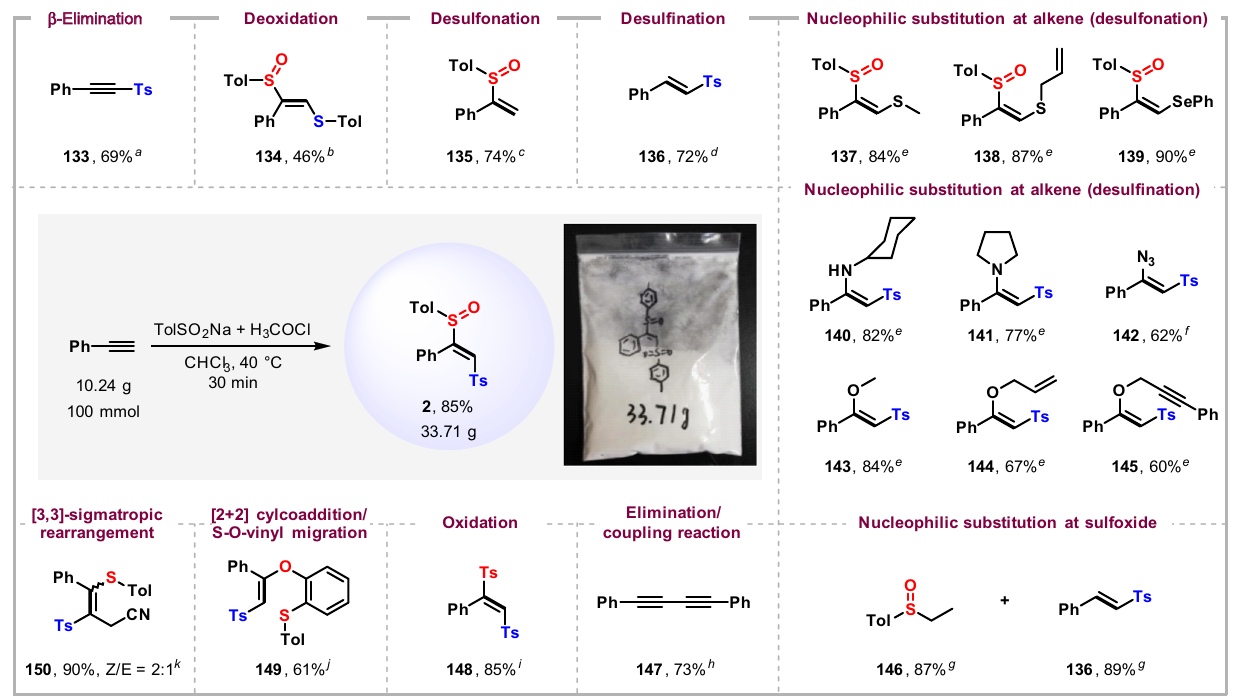
Fig. 5 Large-scale synthesis and further transformations. All yields are isolated yields. The amount of 2 is 0.5 mmol. a NaH (0.75 mmol), CH 3 CN (3.0 mL), 25 °C, 6 h. b DBU (5.0 mmol), toluene (3 mL), 100 °C, 6 h. c Methanol (5.0 mmol), hexamethylphosphoric triamide (HMPA, 2.5 mmol), SmI 2 in THF (0.1 M, 25 mL), THF (1 mL), − 20 °C, N 2 , 2 h. d SmI 2 in THF (0.1 M, 25 mL), methanol/THF (v/v = 1/1, 1 mL), 25 °C, N 2 ; then, 60 °C, 3 h. e NaH (0.75 mmol), RXH (0.75 mmol), CH 3 CN (3 mL), 25 °C, 5 h. f NaN 3 (5.0 mmol), DMSO (3 mL), 25 °C, 0.5 h. g EtMgBr (1.0 mmol), THF (3 mL), 25 °C, N 2 , 3 h. h EtMgBr (1.0 mmol), Ni(acac) 2 (0.005 mmol) THF (3 mL), 25 °C, N 2 , 3 h. i m -CPBA (0.75 mmol), DCM (10 mL), 25 °C, 1 h. j CsF (3.0 mmol),